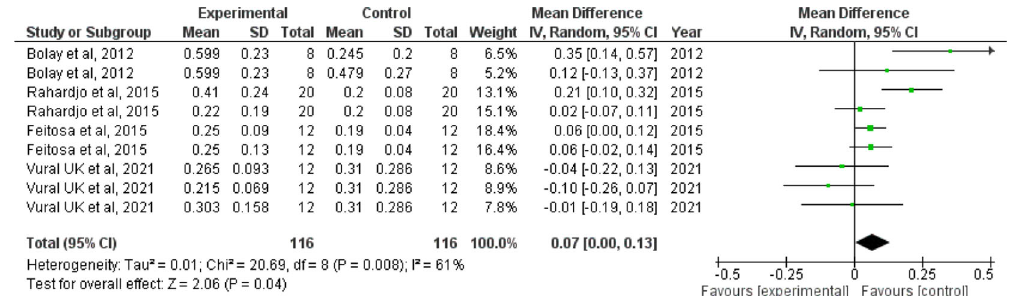
Figure 3. Forest plot comparing the surface roughness of enamel of controls with those brushed with whitening toothpaste.